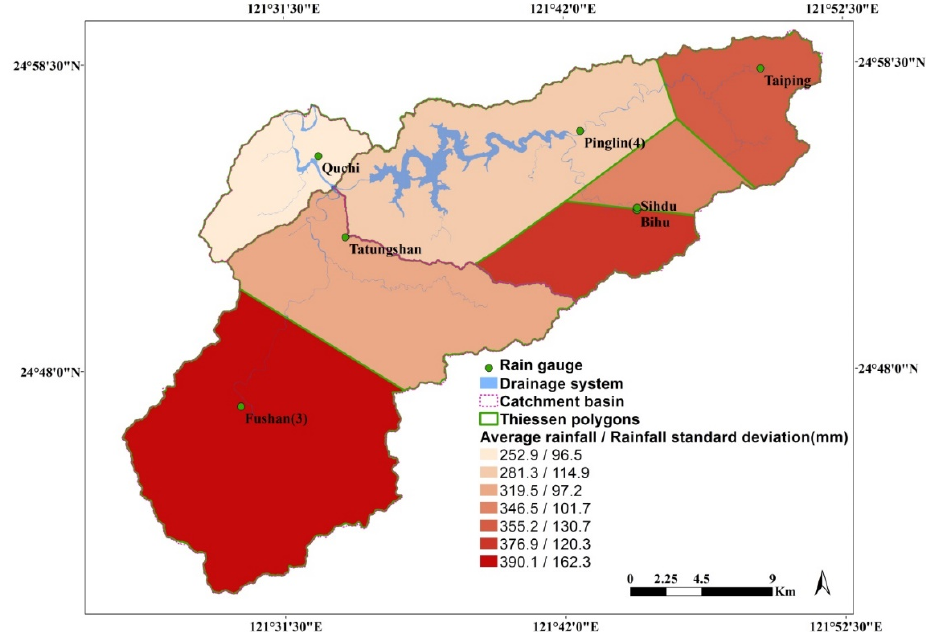
Figure 3. Average daily rainfall and standard deviation of the eight typhoon events in each control area of the rain gauge divided by the modified Thiessen polygon method.